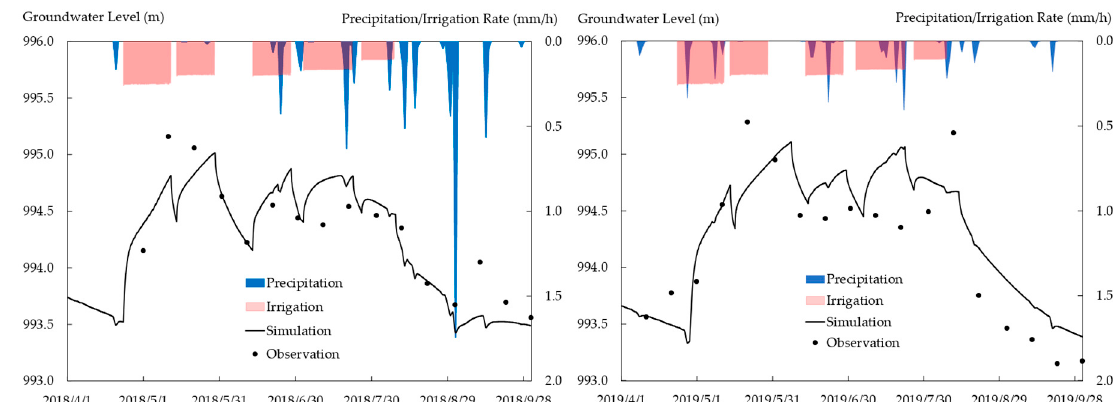
Figure 9. Process of precipitation and irrigation, and the simulated and observed groundwater level at an observation site.